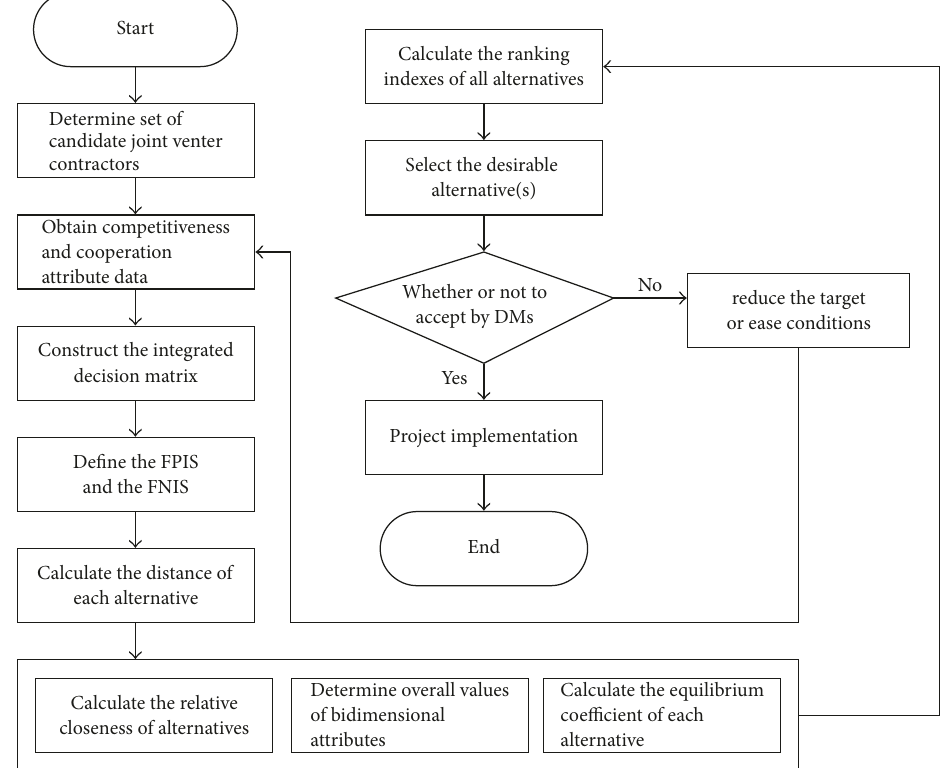
Figure 2: The framework of the method based on ideal